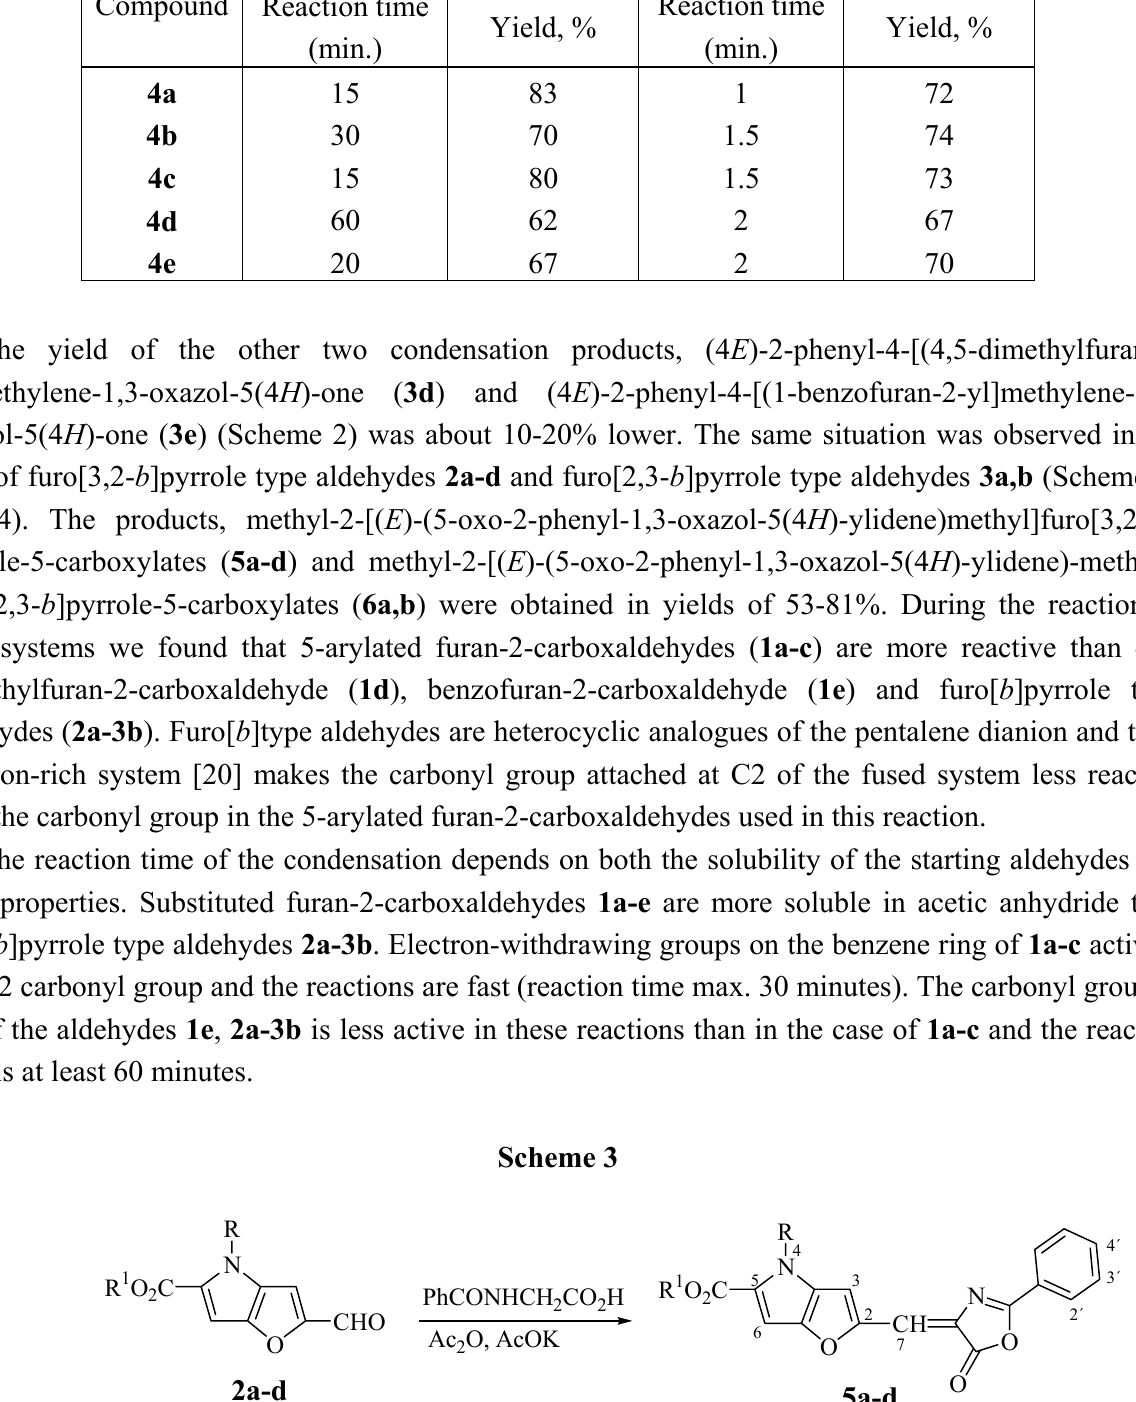
Table 1. Comparisons between “classical” and microwave procedures Classical conditions MW reaction Compound Reaction time Reaction time Yield, % Yield, (min.) (min.)